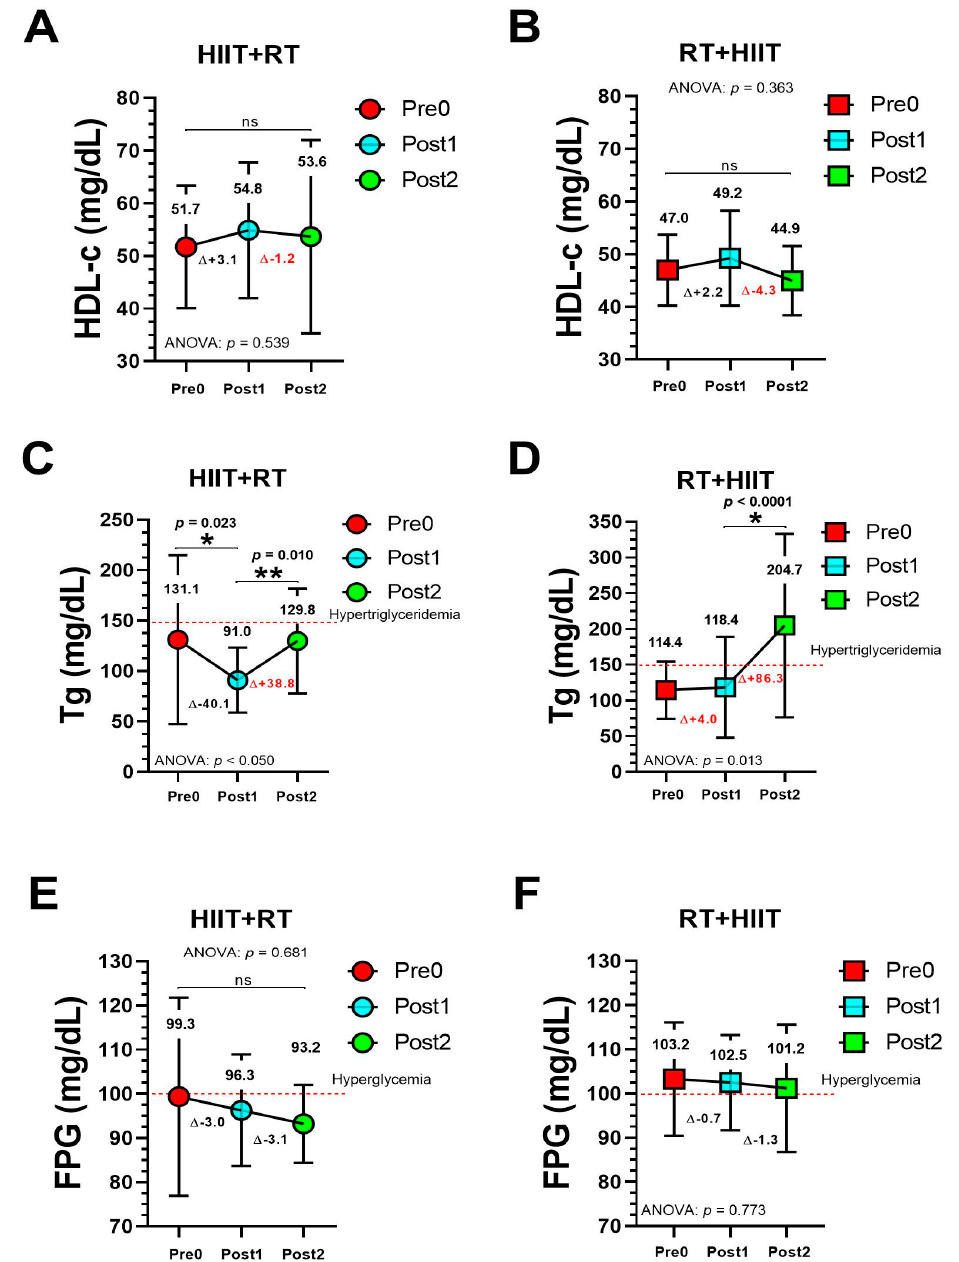
Figure 3. Metabolic syndrome outcomes (HDL-c [panels A , B ], Tg [panels C , D ], and FPG [panels E , F ]) after 20 weeks of different CT orders and after 20 months of COVID-19 confinement. (*) Denotes significant differences at level p < 0.05. (**) Denotes significant differences at level p < 0.001. (ns) Non-significant changes.